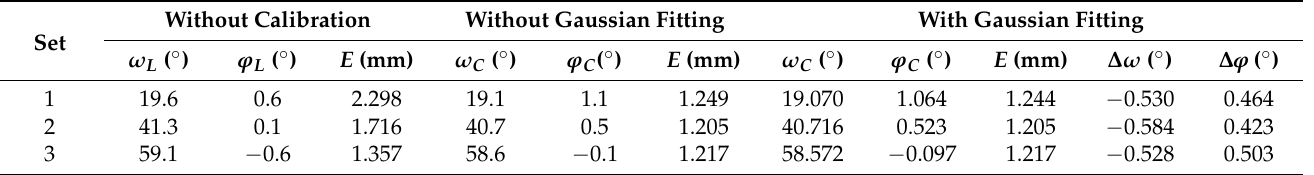
Table 2. Calibration results of eccentric angles and camera orientations.